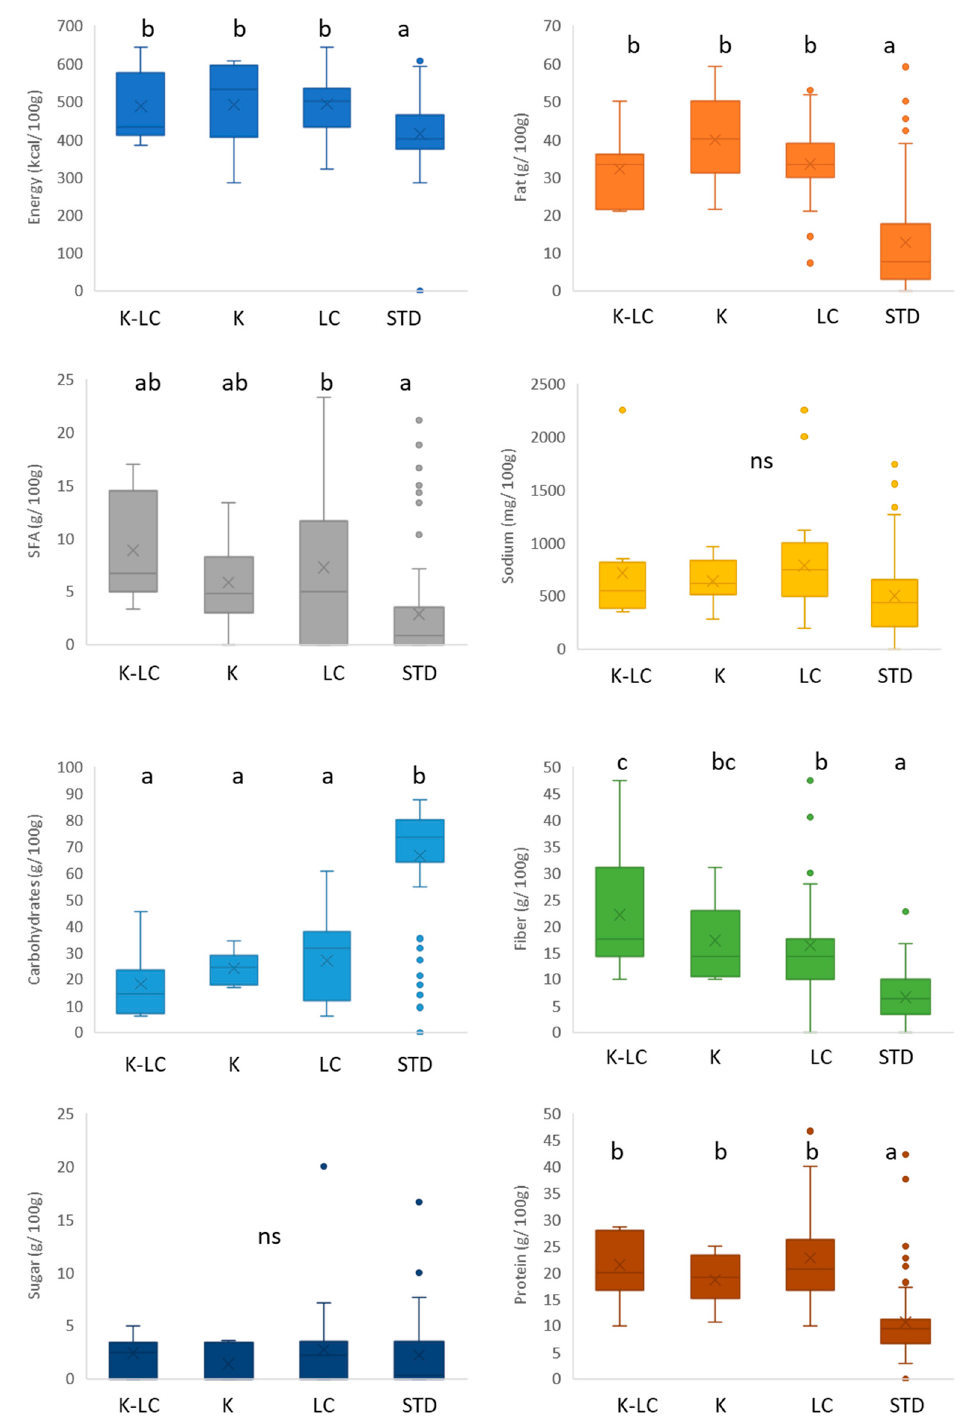
Figure 5. Nutritional composition of gluten-free savory biscuits and crackers labeled ketogenic and/or low carb. K-LC: ketogenic and low carb; K: ketogenic; LC: low carb; STD: standard; different letters indicate significant difference at p < 0.05; ns: non-significant; the box-plot legend: the box is limited by the lower (Q1 = 25th) and upper (Q3 = 75th) quartile; the median is the horizontal line dividing the box; whiskers above and below the box indicate the 10th and 90th percentiles; outliers: are the points outside the quartile 10–90th percentiles.